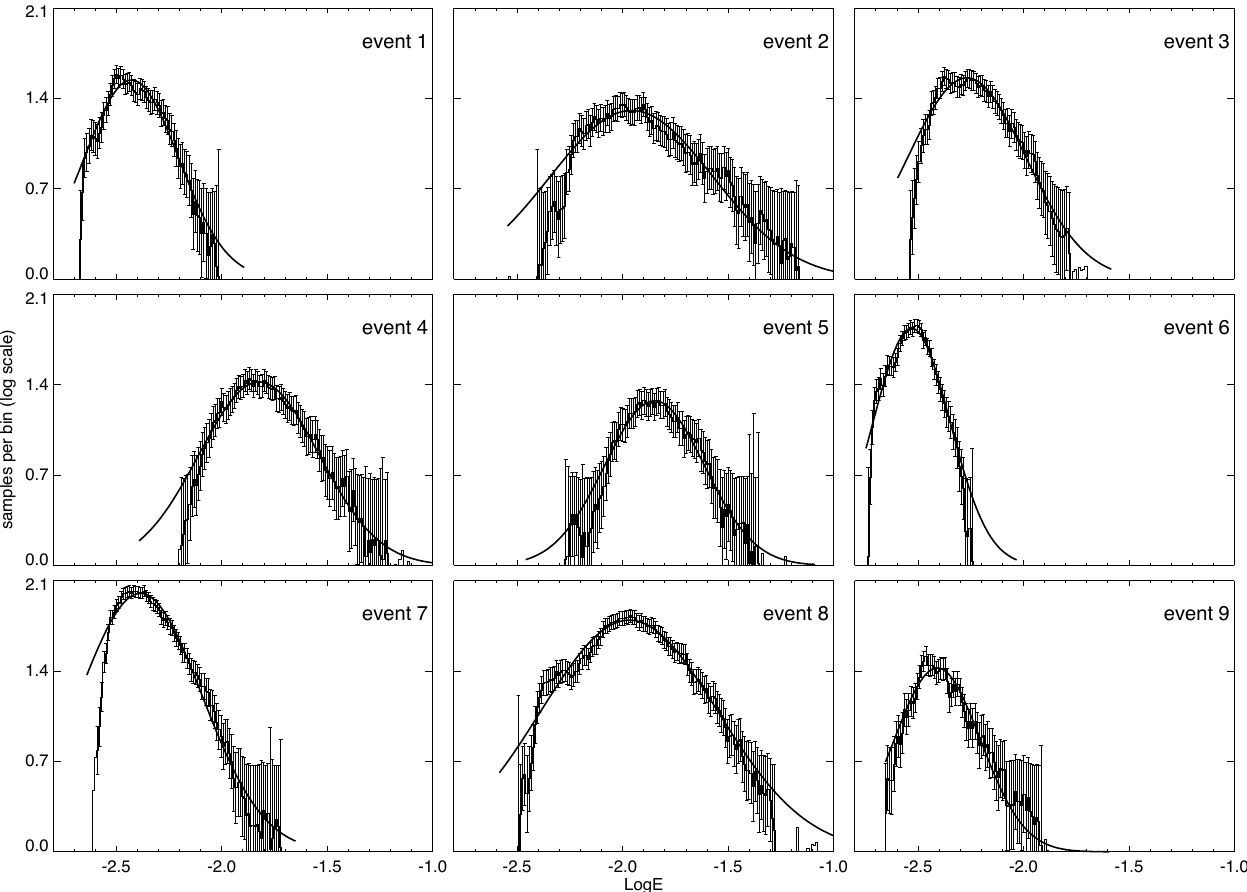
Fig. 5. Histograms of the effective number of samples, N eff , versus the logarithm of the electric field amplitude, applying a 2.6ms running average, for all nine events labeled in Fig. 1b. Lighter traces show Gaussian models (in log E) ) fitted to the observed range of fields. Error bars reflect estimates of statistical uncertainty as described in the text.